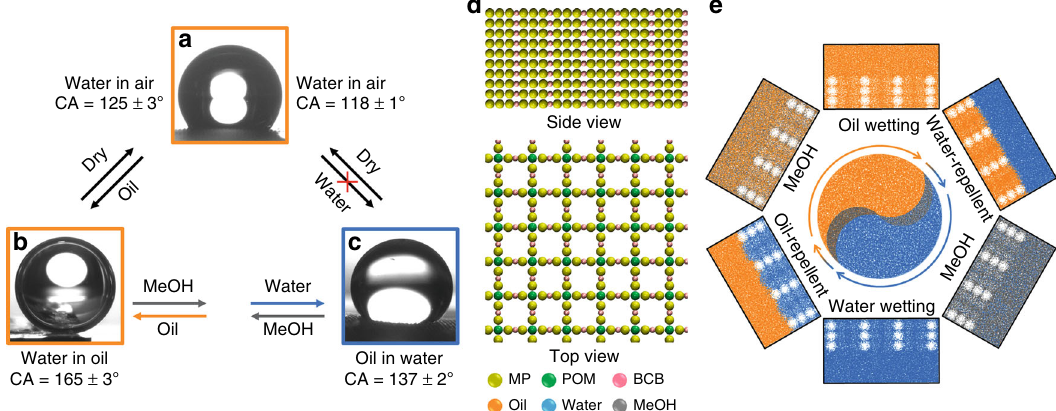
Fig. 5 Surface property and DPD simulation of separation process. a – c Static contact angle changes from ( a ) dried framework membrane through ( b ) wetting with chloroform to ( c ) the one washing with methanol and water, and then getting back to dried state, data are collected to get average values ( n = 5). d – e The DPD packing model in ( d ) top and side views, in which the chemical species are extracted as particles with corresponding properties, where MP represents methyl-pillar[5]arene and the oil denotes non-polar liquids like carbon tetrachloride. Source data are provided as a Source Data fi